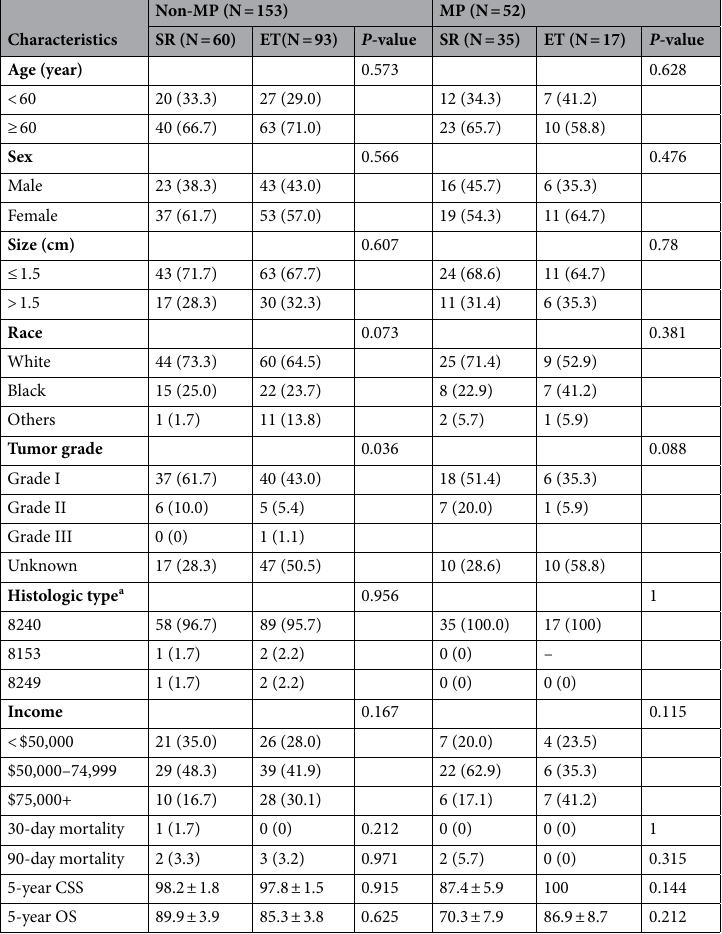
Table 4. Distribution profiles of the clinicopathologic factors of the patients in the endoscopic treatment group and surgical resection group in different depth of tumor invasion. ET endoscopic treatment,